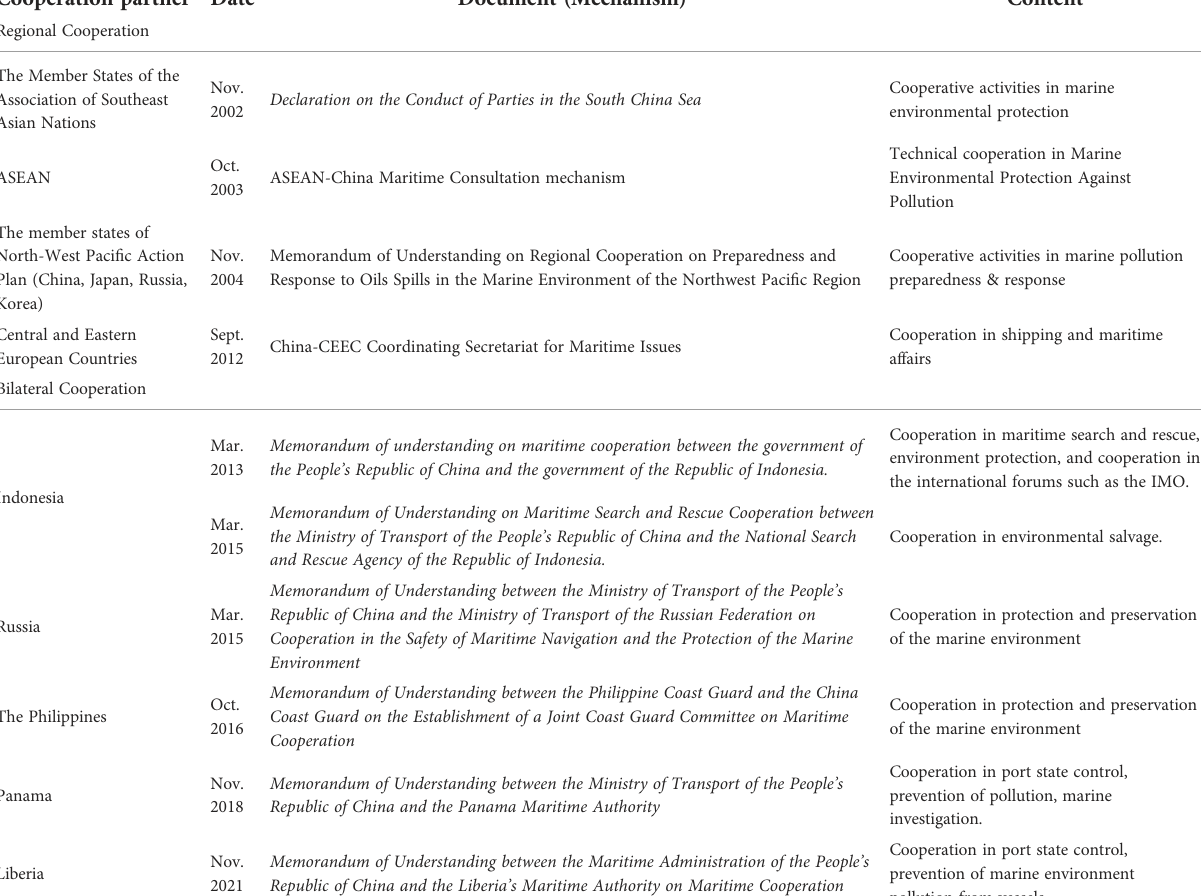
TABLE 2 China ’ s cooperation in the fi eld of marine